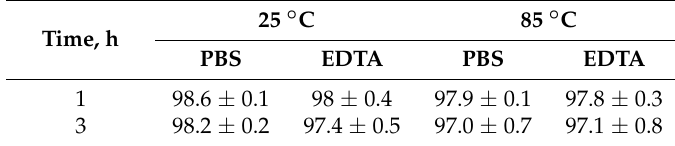
Figure 3. Distribution of activity of purified [ 68 Ga]Ga-DFO-ZEGFR:2377 labeled at 85 ◦ C along ITLC strip. Retardation factor of affibody molecule is 0.0 and that of free 68 Ga is 1.0. Table 2. Stability of 68 Ga-DFO-ZEGFR:2377 in phosphate-buffered saline (PBS) and under EDTA challenge 1 .